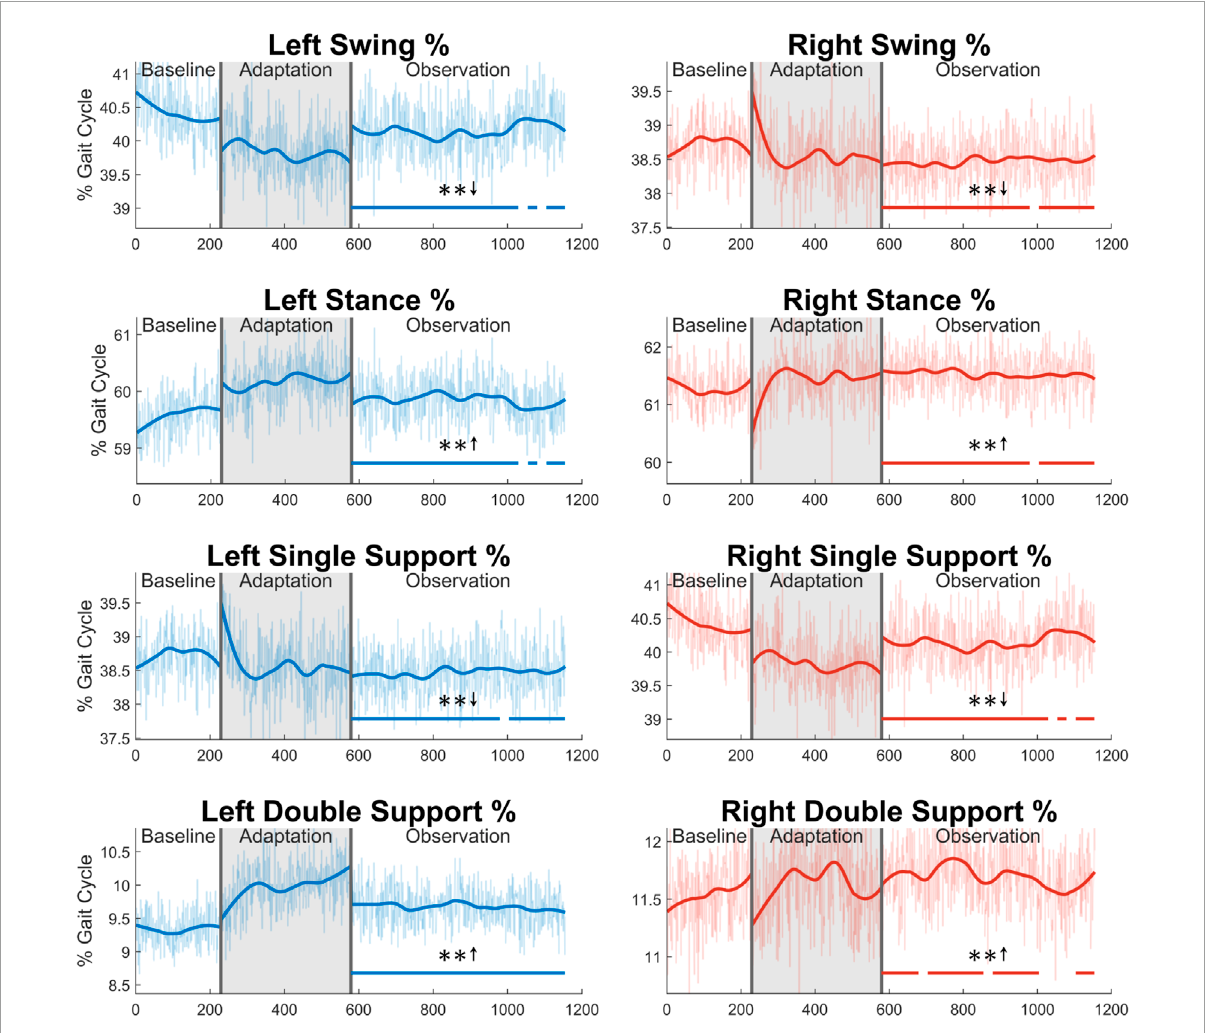
FIGURE 13 Sections of the gait cycle displayed with respect to how much of the entire gait cycle they occupy (in terms of percentage). The double support phase is determined to be left or right depending on which foot is in front and has more recently achieved heel strike. Significance is shown in the observation phase as compared to the baseline phase by the significance line. All significance testing was performed on “unsmoothed” data (seen in the lighter line). The darker line is the data smoothed by 2nd-degree polynomial local regression and was added only to allow the reader to more clearly see trends in the